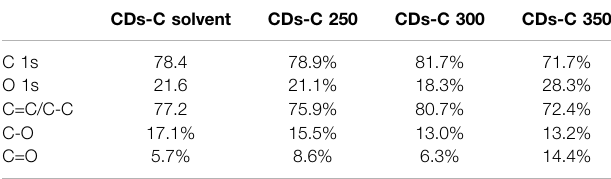
TABLE 1 | Elemental proportions and chemical bonds in cellulose based CDs.